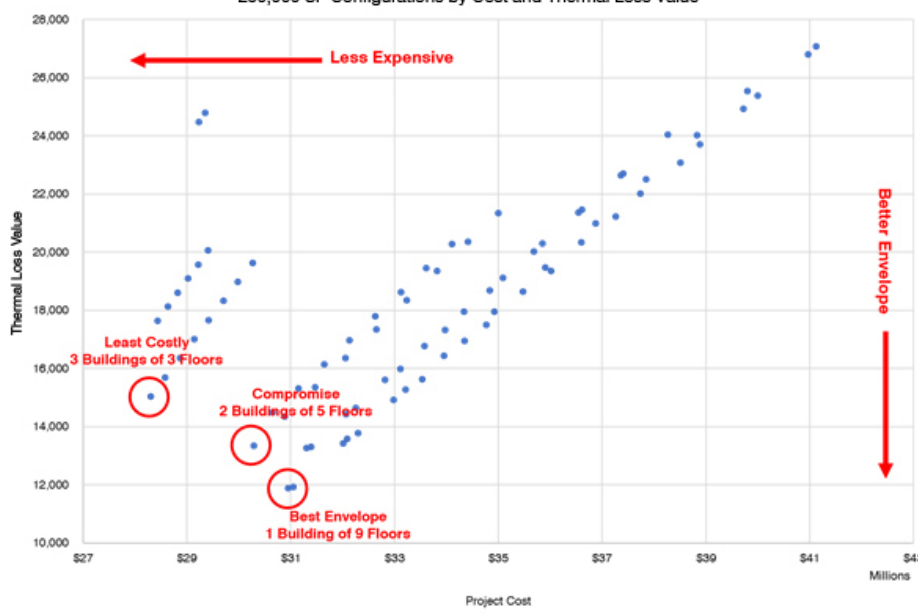
Figure 13. Solutions for 250,000 square foot Complex by Cost and Thermal Loss Value.